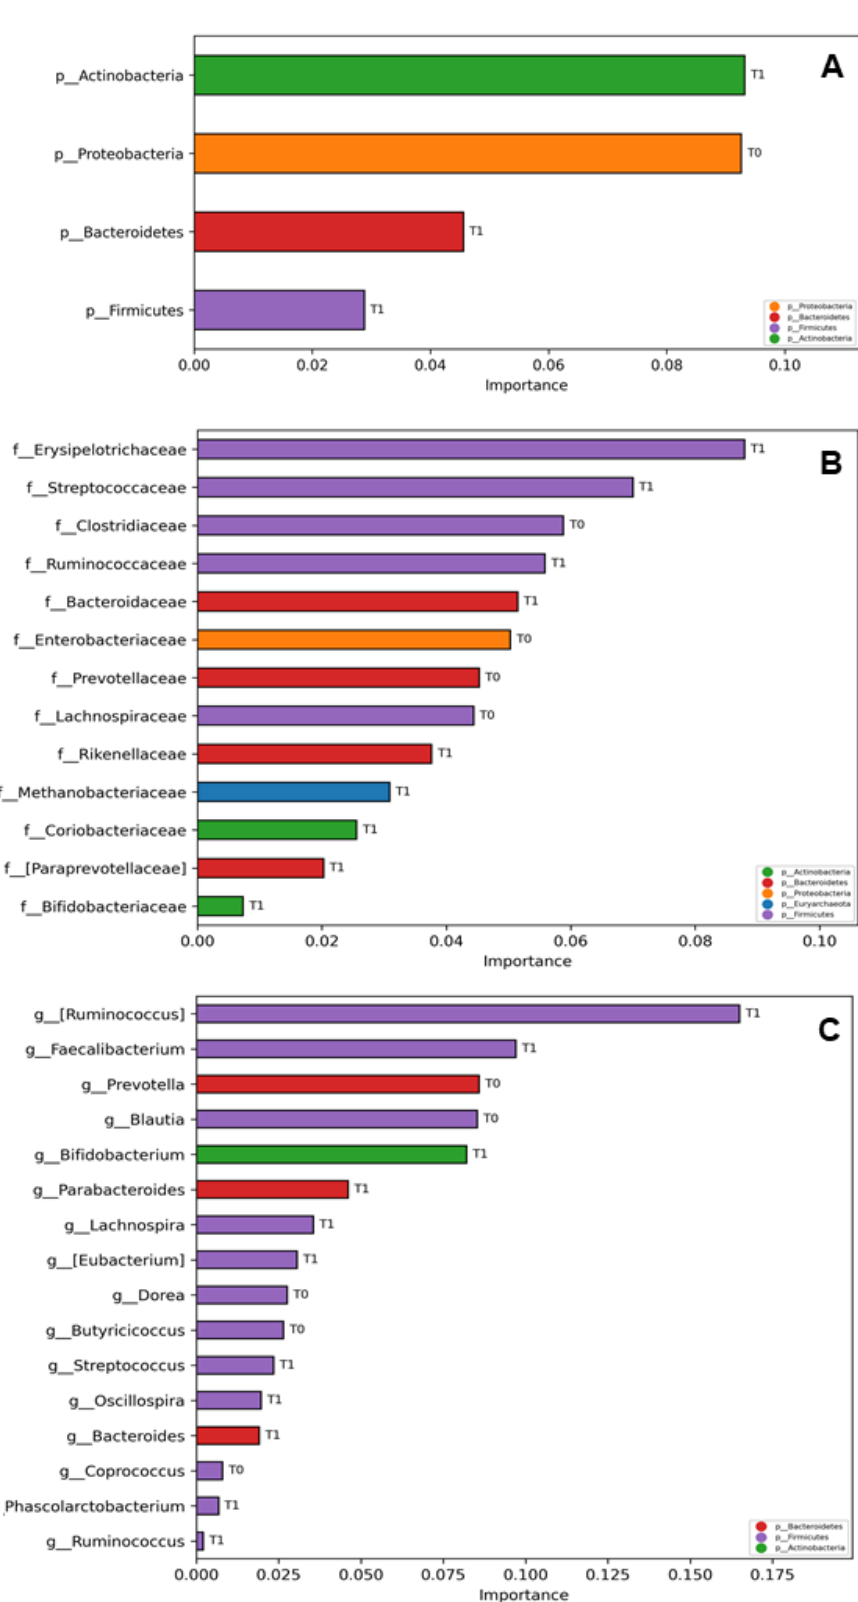
Figure 6. Multiple machine learning (ML) models trained to classify the patients’ gut microbiota at T 1 versus T 0 for each taxonomy level of the corresponding ASVs, selected by the model classification analysis as “important” features. The bars represent the importance scores of each ASV in the prediction of models. Important ASVs for model prediction are represented at Phylum level (L2) ( A );